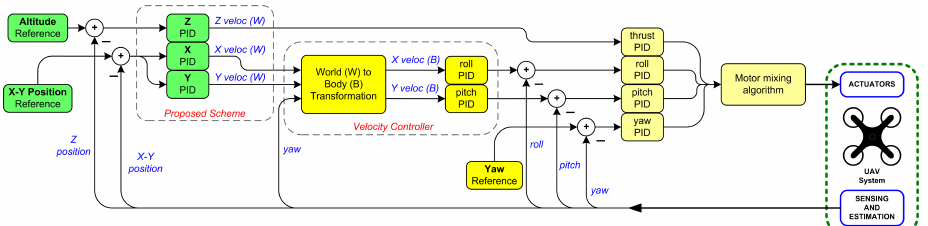
Figure 2. Schematic of the Simplified Cascaded-PID controller.